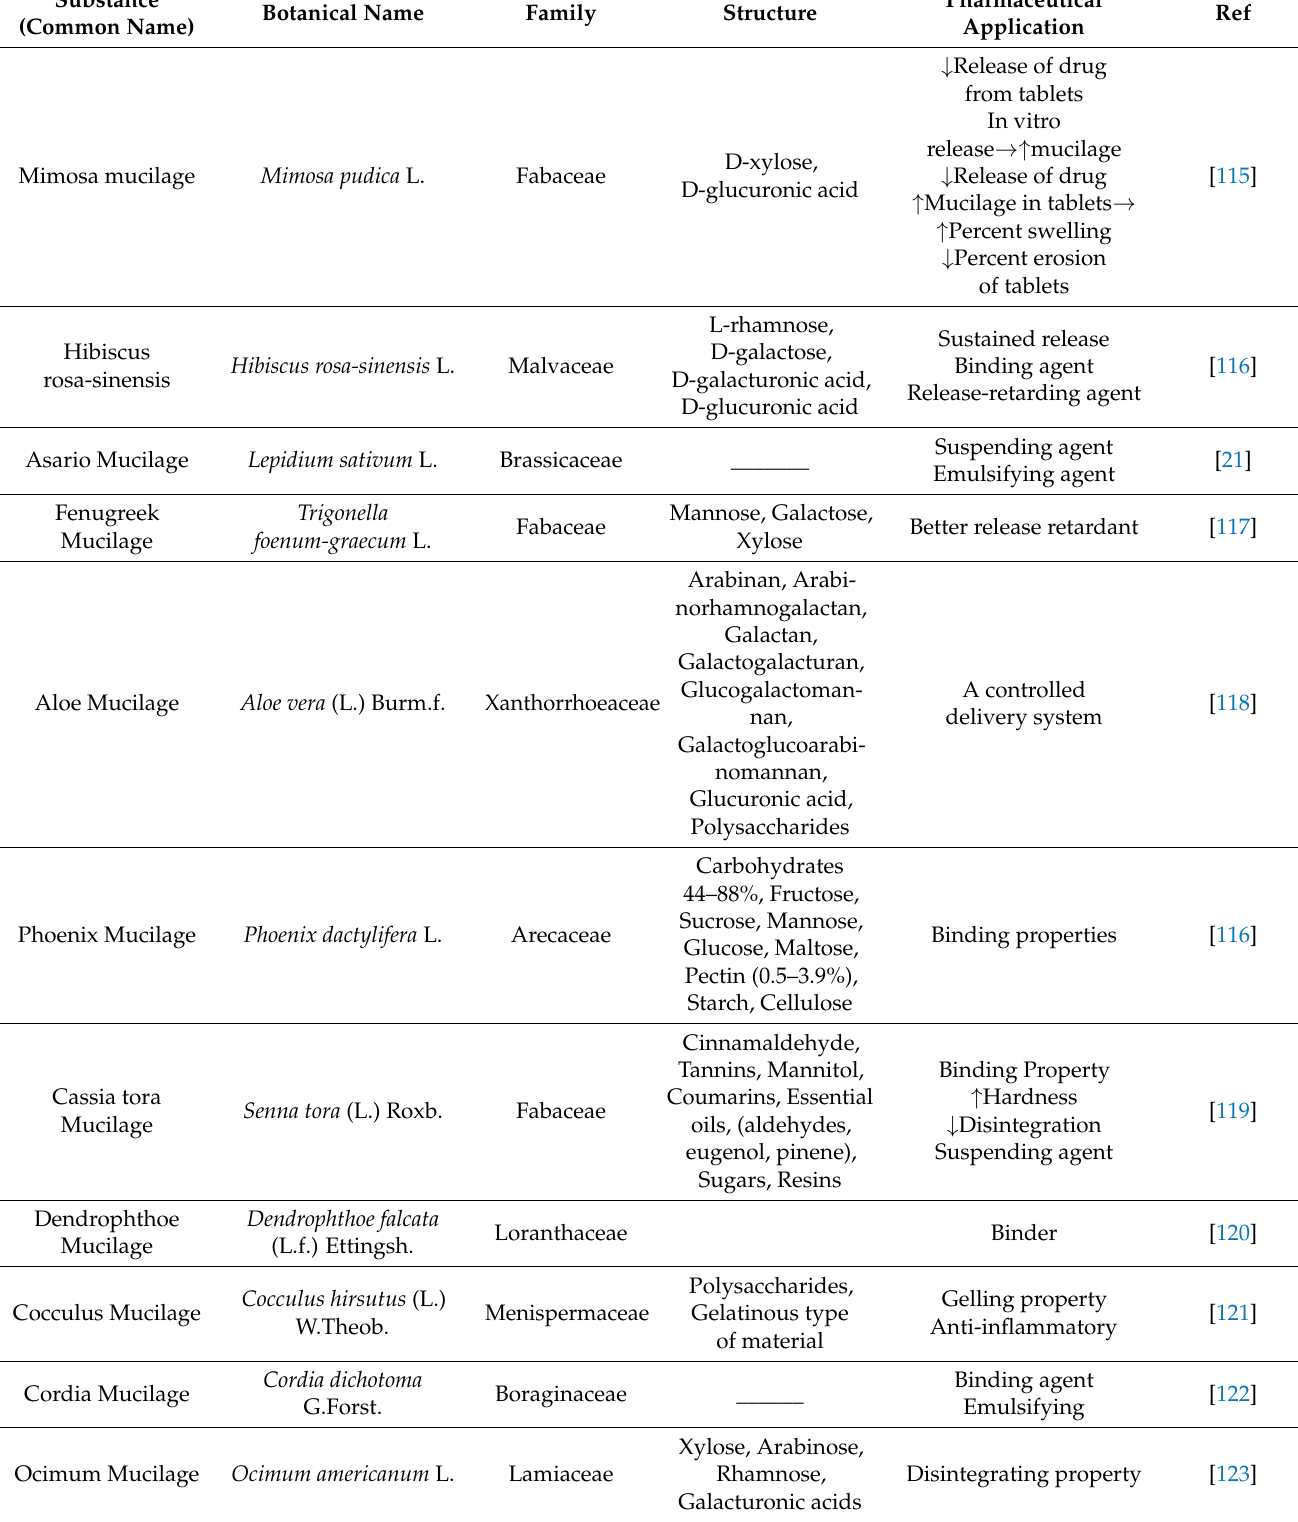
Table 2. Some of the most important botanical sources of mucilage and their pharmaceutical applications.